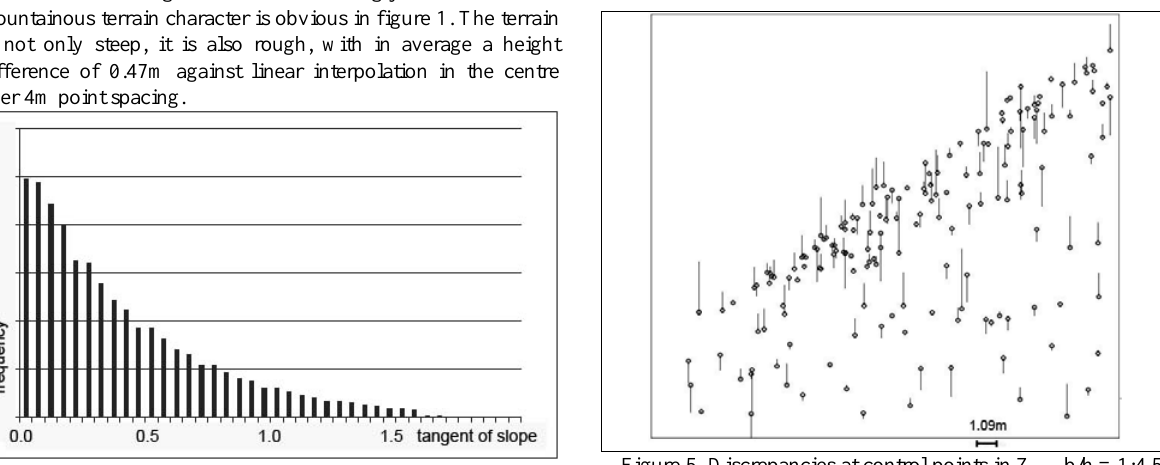
Figure 3. Frequency distribution of terrain slope